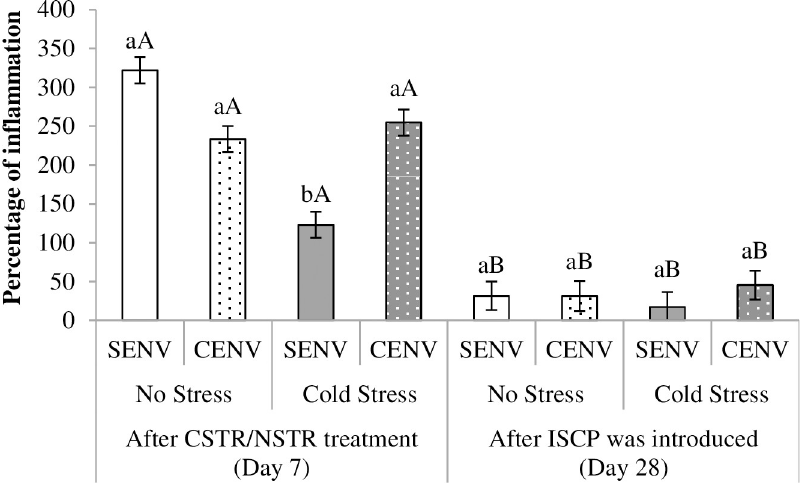
Fig 8. Mean ( ± SE) percentage of inflammation measured after PHA-P injection. ( a-b) letters indicate differences between different treatments at each injection time i.e. Day 7 of age (five days after Cold Stress (CSTR)/No Stress (NSTR) treatment) and Day 28 of age (after the ISCP was applied); (A-B) letters indicate differences across time within the same treatment; NSTR treatment is represented by white bars; CSTR by grey bars; SENV is represented by bars with a solid colour; CENV by bars with